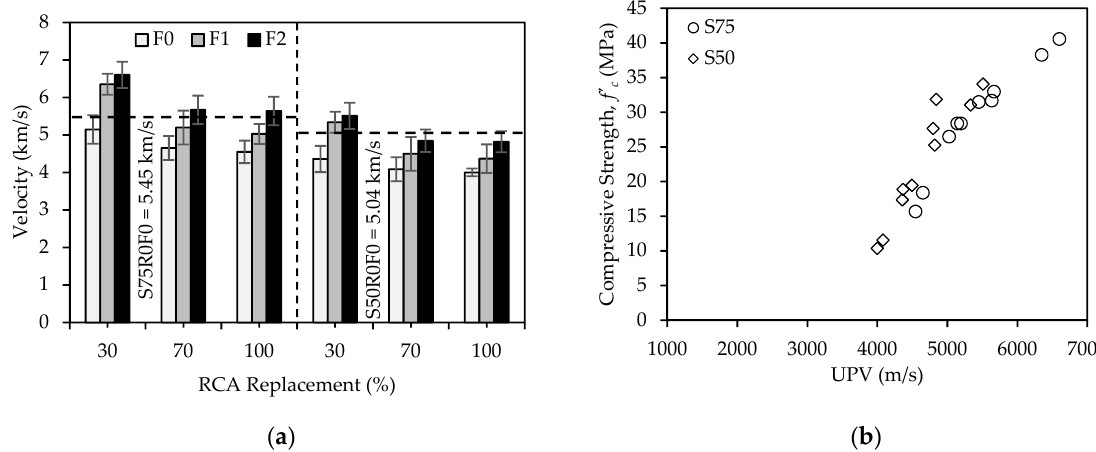
Figure 19. ( a ) Ultrasonic pulse velocity of alkali-activated slag-fly ash blended concrete as a function of RCA replacement and ( b ) relationship between UPV and f’ c .